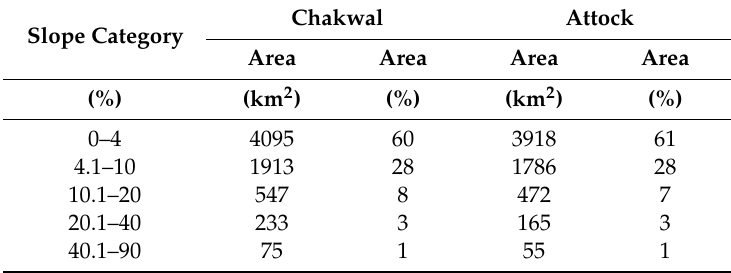
Table 6. Slope classification analysis of the Chakwal and Attock districts. Slope